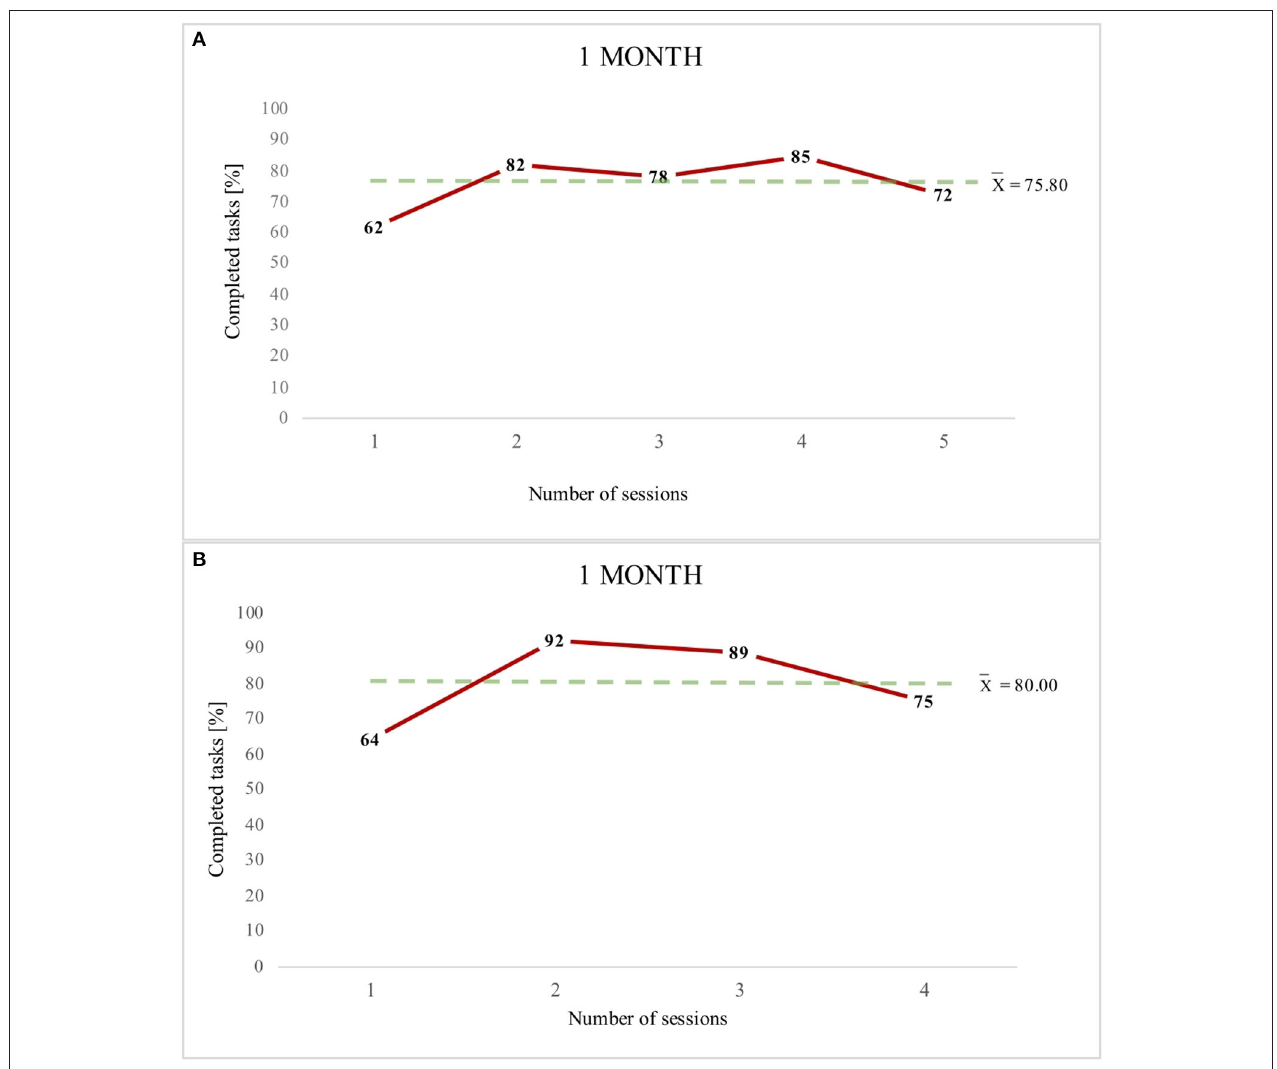
FIGURE 2 | Patients 1- graph (A) and Patient 2- graph (B) (1 month of work with the device).